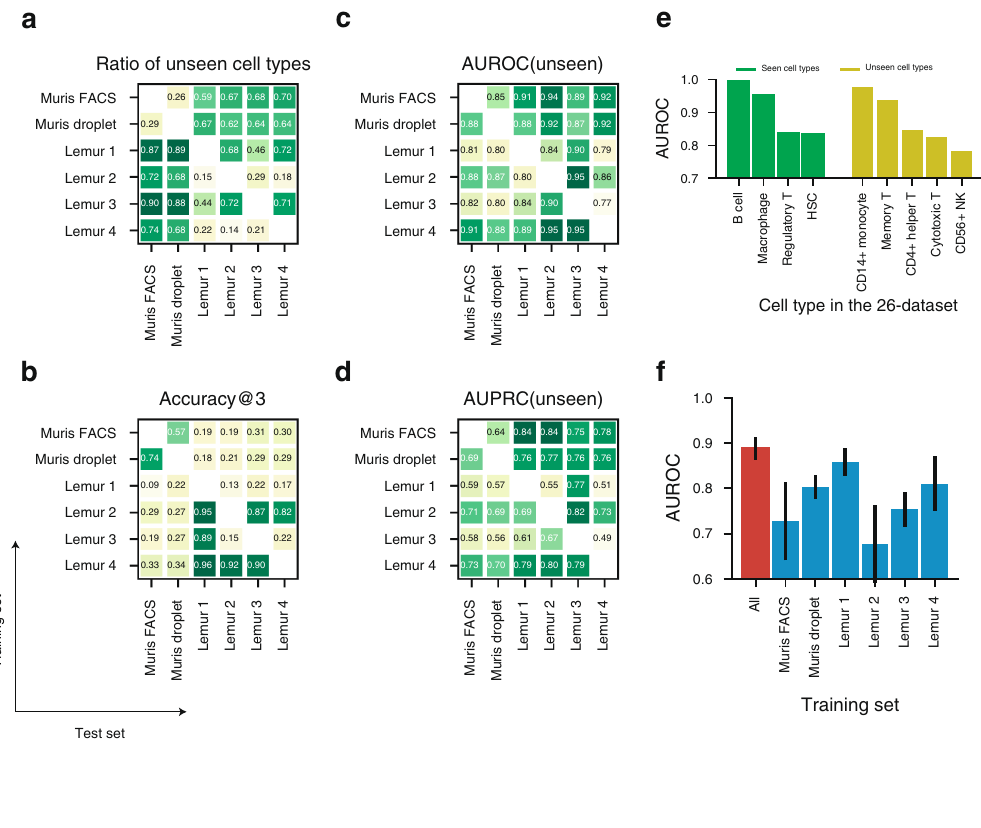
Fig. 4 Training with different datasets and proportions of unseen cell types highlights OnClass versatility and accuracy. a – d Heatmaps showing the ratio of unseen cell types ( a ), Accuracy@3 ( b ), unseen AUROC ( c ), and unseen AUPRC ( d ) in cross-dataset prediction. The x -axis is the test set and the y - axis is the training set. e Bar plot showing the AUROC of OnClass on 9 cell types, including 4 present in the training set (green) and 5 not present in the training set (yellow). f Bar plot showing the AUROC of OnClass using all six datasets (red) and each individual dataset (blue) as the training set to classify cells in the 26-dataset. Error bar represents standard errors. Mean is used to measure the centre for the error bar. NATURE COMMUNICATIONS| (2021) 12:5556